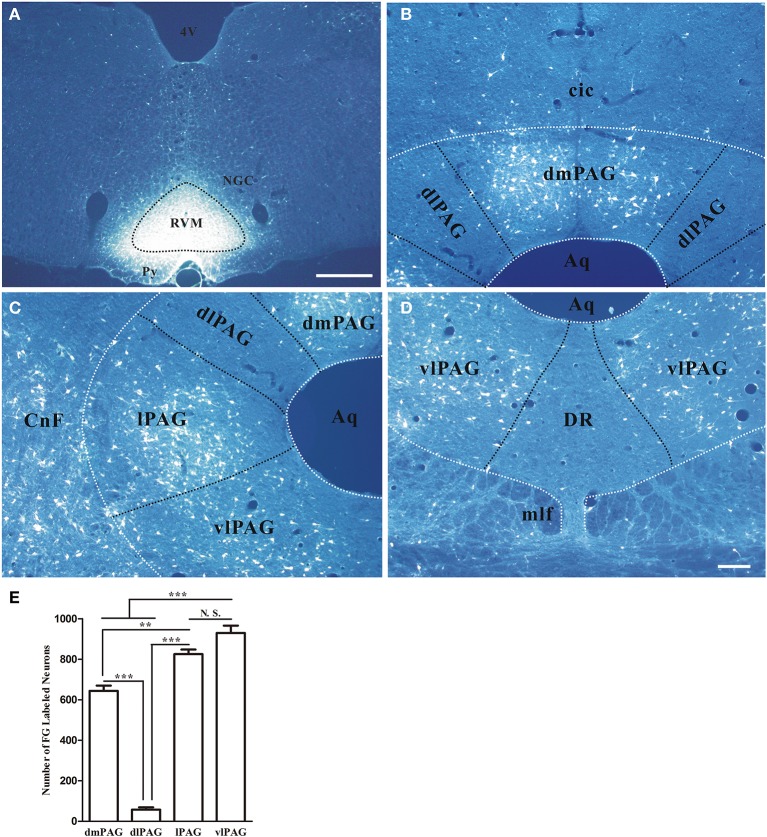
Distribution of retrogradely labeled neurons in the PAG after FG was injected into the raphe magnus nucleus. (A) Fluorescent photomicrograph shows FG injection site in the raphe magnus nucleus and its adjacent regions. Scale bar = 200 μm. (B–D) Fluorescent photomicrographs show the general distributing patterns of FG retrogradely labeled neurons from the RVM in the four subregions of the PAG. FG labeled neurons were observed in the dmPAG (B), lPAG (C), vlPAG (D). In the dlPAG (B) and DR (D), few FG labeled neurons were seen. Scale bar = 100 μm. (E) Summary of the numbers of FG labeled neurons in four subregions of the PAG. (Mean ± SD) N.S. no significant, **
P < 0.01, ***
P < 0.001, One-Way ANOVA, Dunnett's Test. 4V, 4th ventricle; cic, commissure of the inferior colliculus; CnF, cuneiform nucleus; DR, dorsal raphe nucleus; NGC, gigantocellular reticular nucleus; Py, pyramidal tract; RVM, rostroventral medial medulla.